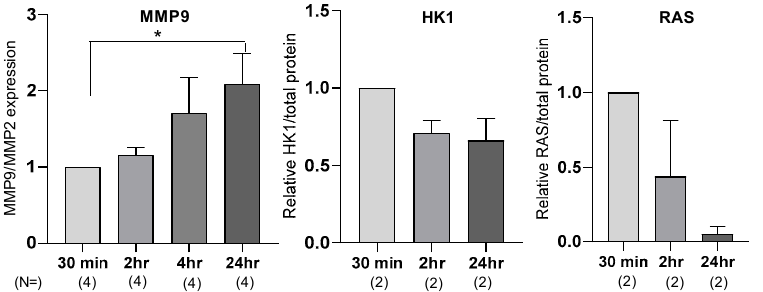
Figure 1. Sample processing time a ff ects plasma MMP9, HK1, and RAS expression levels. Plasma MMP9, HK1, and RAS expression levels were measured at di ff erent time points: 30 min, 2 h, 4 h, and 24 h after blood draw. MMP9 expression was measured by luminex xMAP technology. Ras and HK1 expression were measured by Western blot. N represents number of independent biological replicates. Statistical significance was measured by Student’s t-test when n ≥ 3; * represents p < 0.05; error bars represents mean ± standard error of mean. Target protein expression levels were normalized to the 30 min time point to determine change in expression with time.